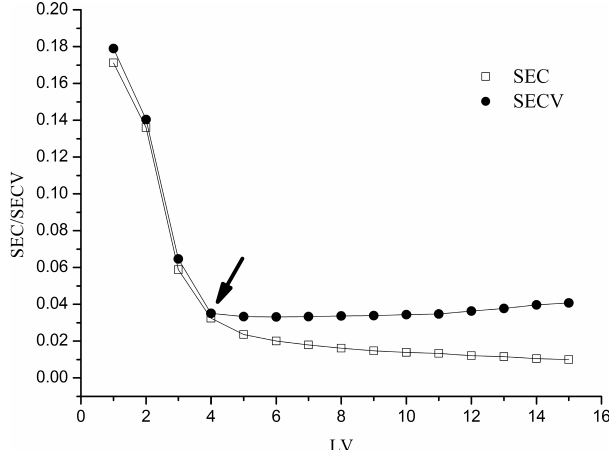
acid.Fig. 5. Correlogram of the NIR spectra and secologanic acid